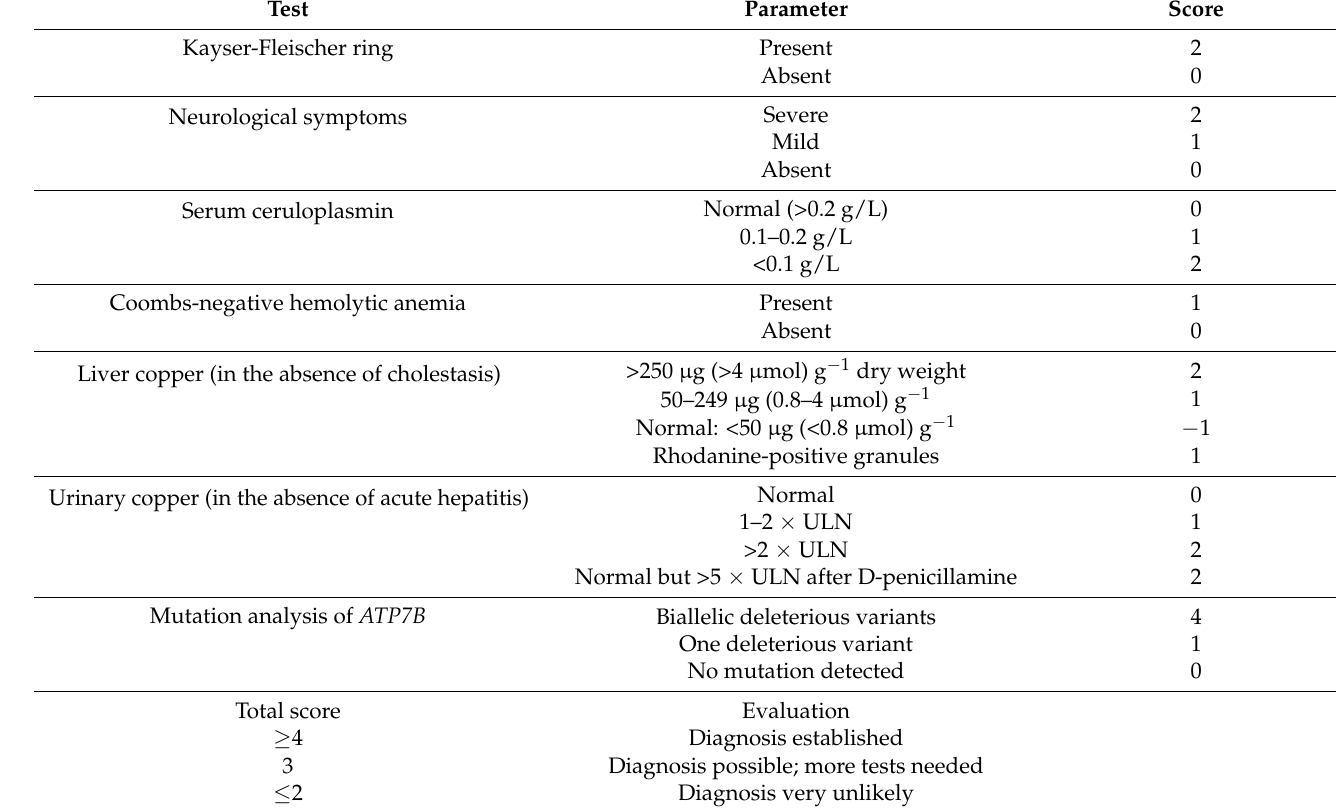
Table 1. Diagnostic scoring system for Wilson’s